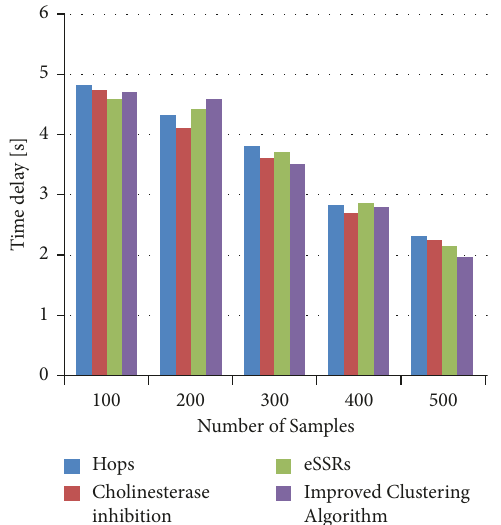
Figure 7: The execution delays of the integrated